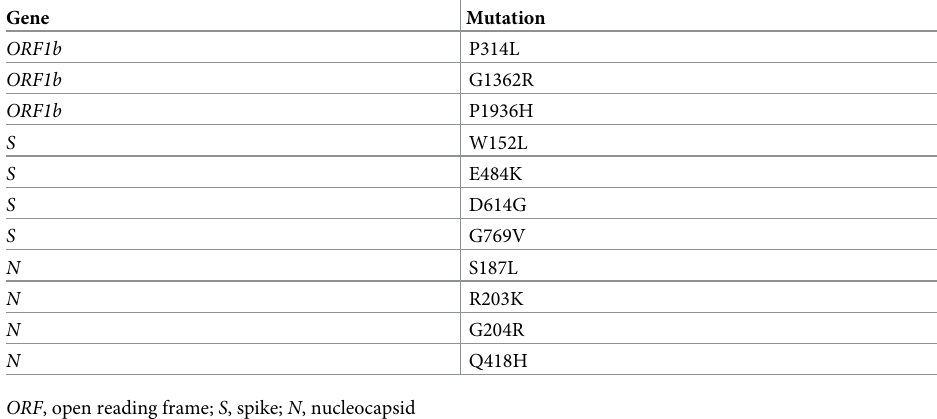
Table 1. Common mutations in the SARS-CoV-2 R.1